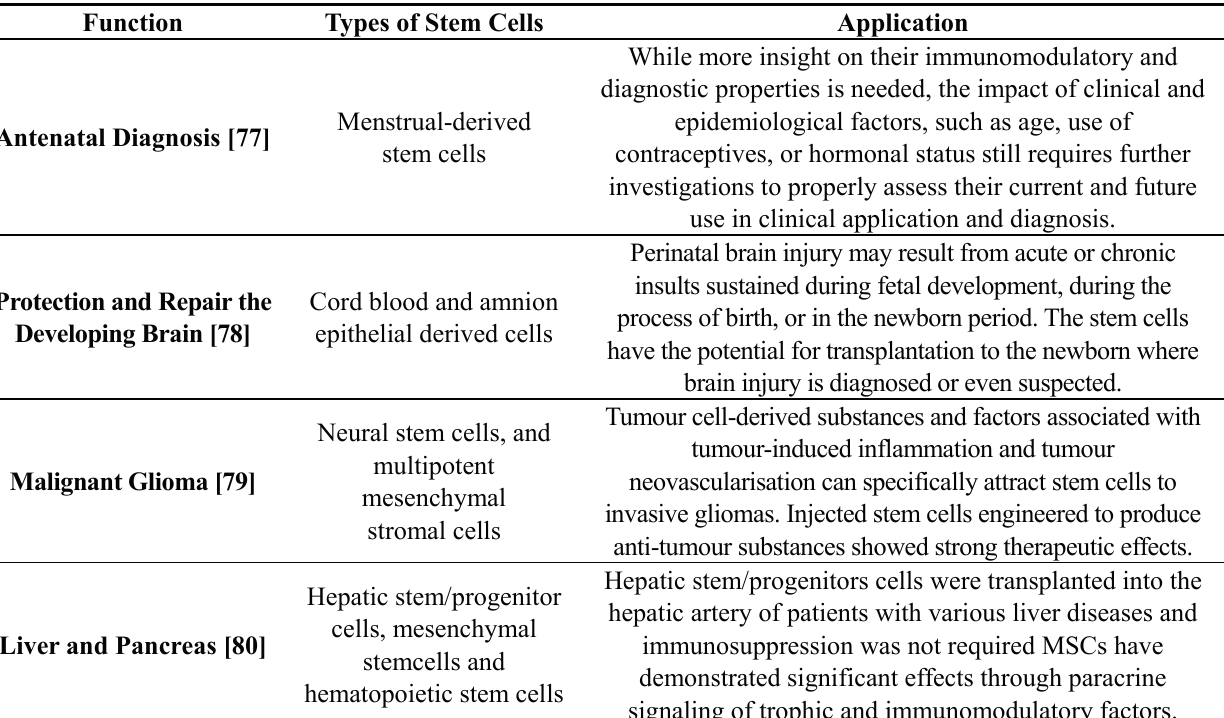
Table 2. Stem cell therapy used in other